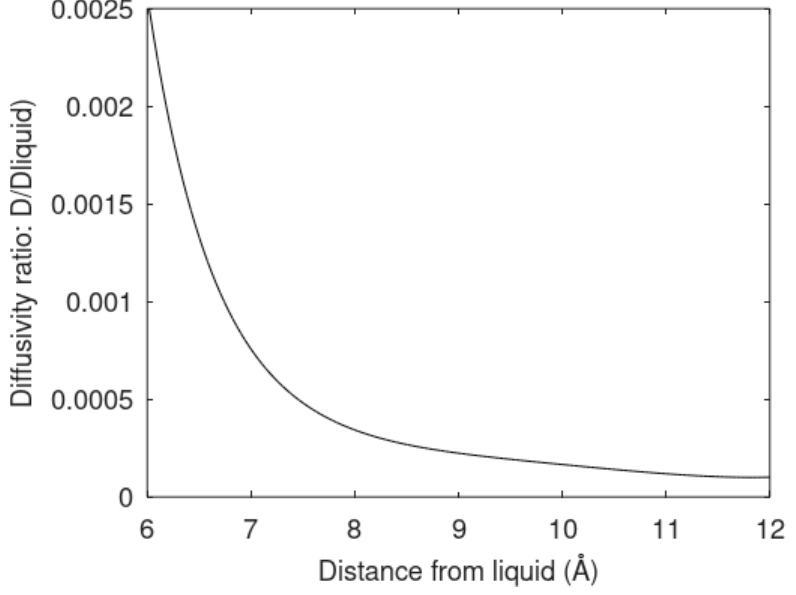
Figure 12. Same as Figure 11 for the second half of the interface close to the hydrate side of the interface.